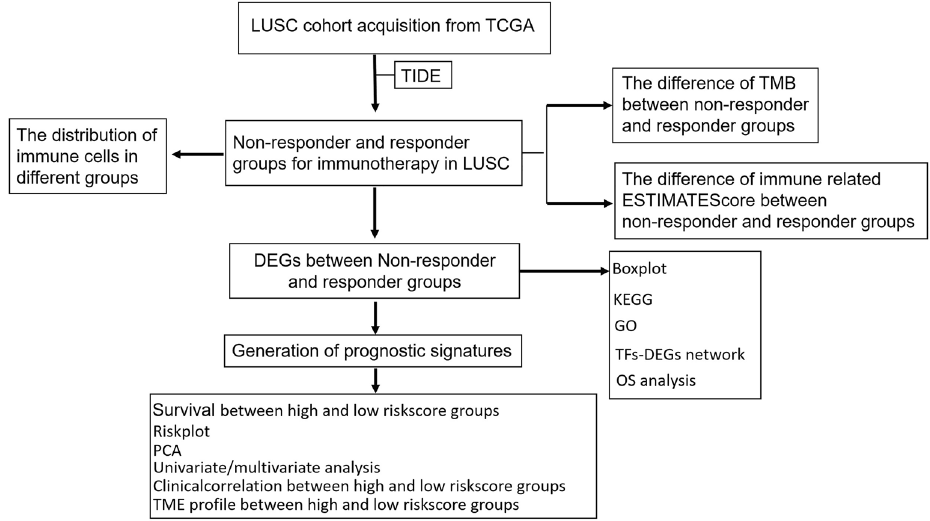
Figure 1. Flow chart for the construct and validation of a DEGs related prognosis